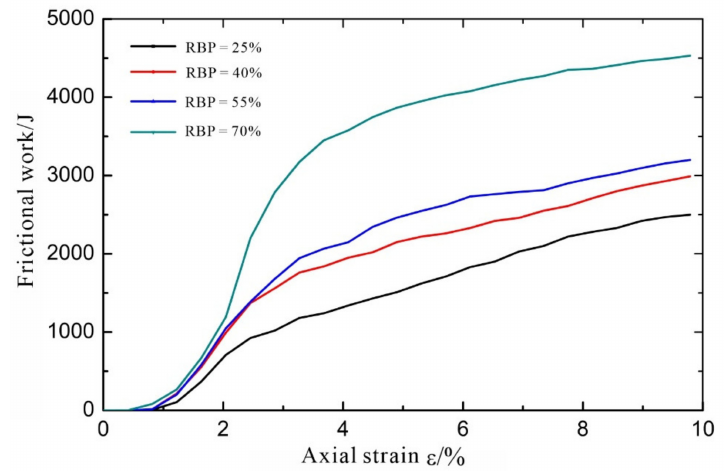
Figure 12. Relationship between frictional work and